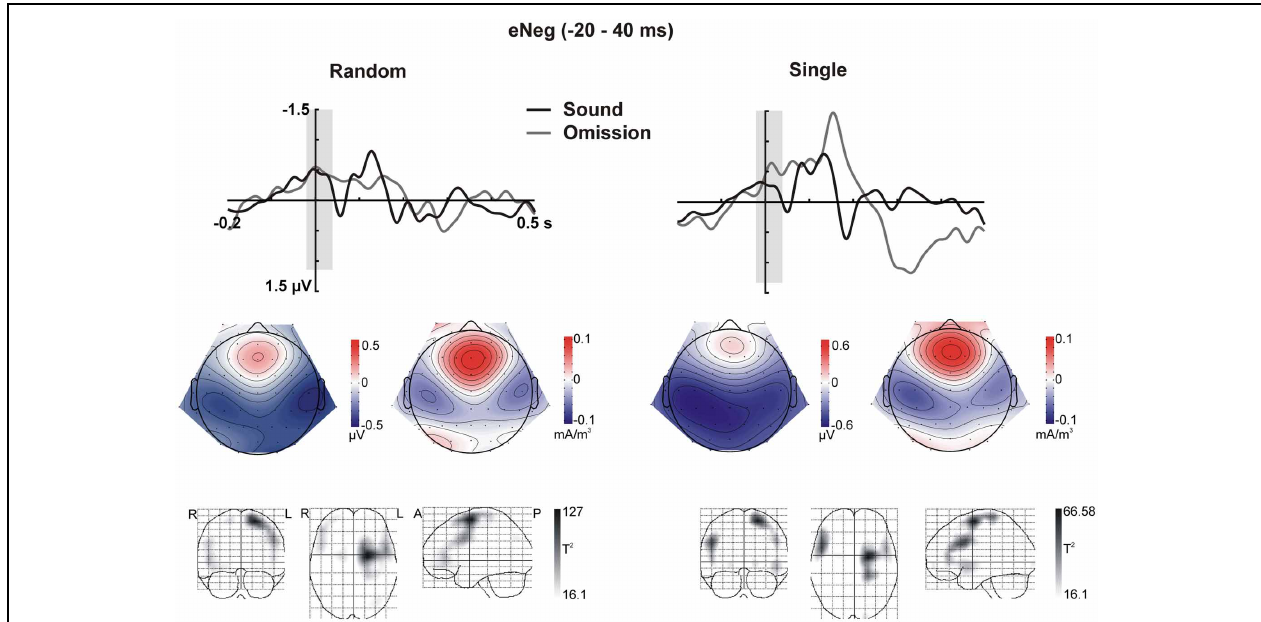
current density (right) maps for the motor-corrected omission response in the marked eNeg window. Bottom row: Statistical parametric maps of the VARETA source estimation for the sound omission vs. motor control contrast in the eNeg time-window. Maps are thresholded at p < 0 . 001. The solution maximum for both the single and the random conditions is located at Talairach coordinate x = − 21, y = − 4, z = 63, corresponding to superior frontal gyrus (SFG), Brodmann area 6